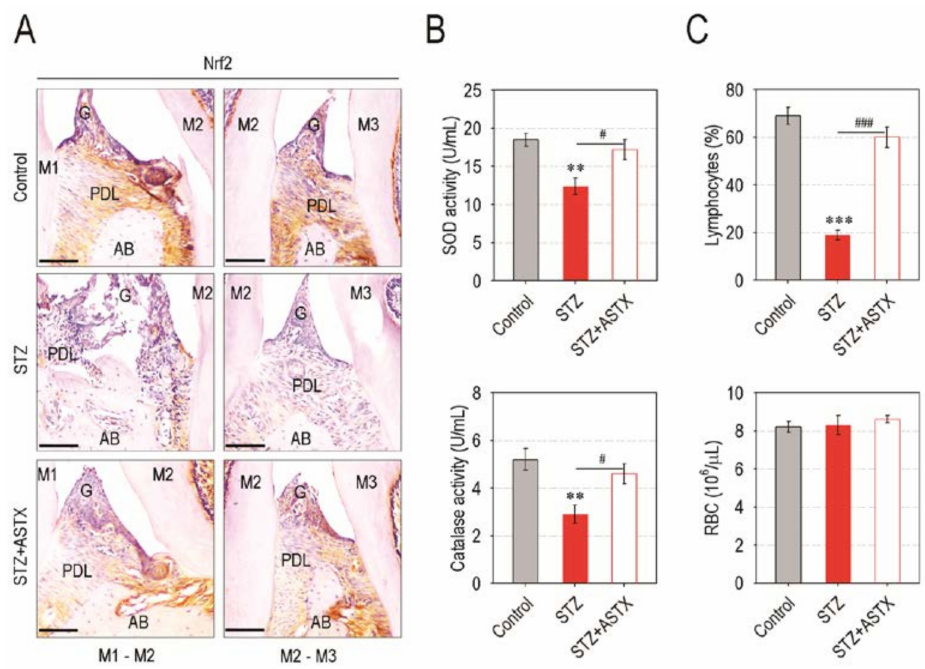
Figure 6. ASTX treatment restores the levels of Nrf2, antioxidant enzymes, and circulating lympho- cytes in STZ-induced diabetic mice. ( A ) Expression level of Nrf2 in the region of upper molars of mice groups were determined by IHC 60 days after hyperglycemia induction (200 × magnification). Bar = 100 µ m. ( B ) The activities of SOD and catalase in blood serum of mice groups were examined using their specific assay kits ( n = 5). ( C ) Circulating levels of lymphocytes and RBC in mice groups were calculated using a blood cell counter ( n = 5). The enzyme activities and blood cell numbers were checked 60 days after hyperglycemia induction. ** p < 0.01 and *** p < 0.001 vs. control group; # p < 0.05 and ### p < 0.001 vs. STZ